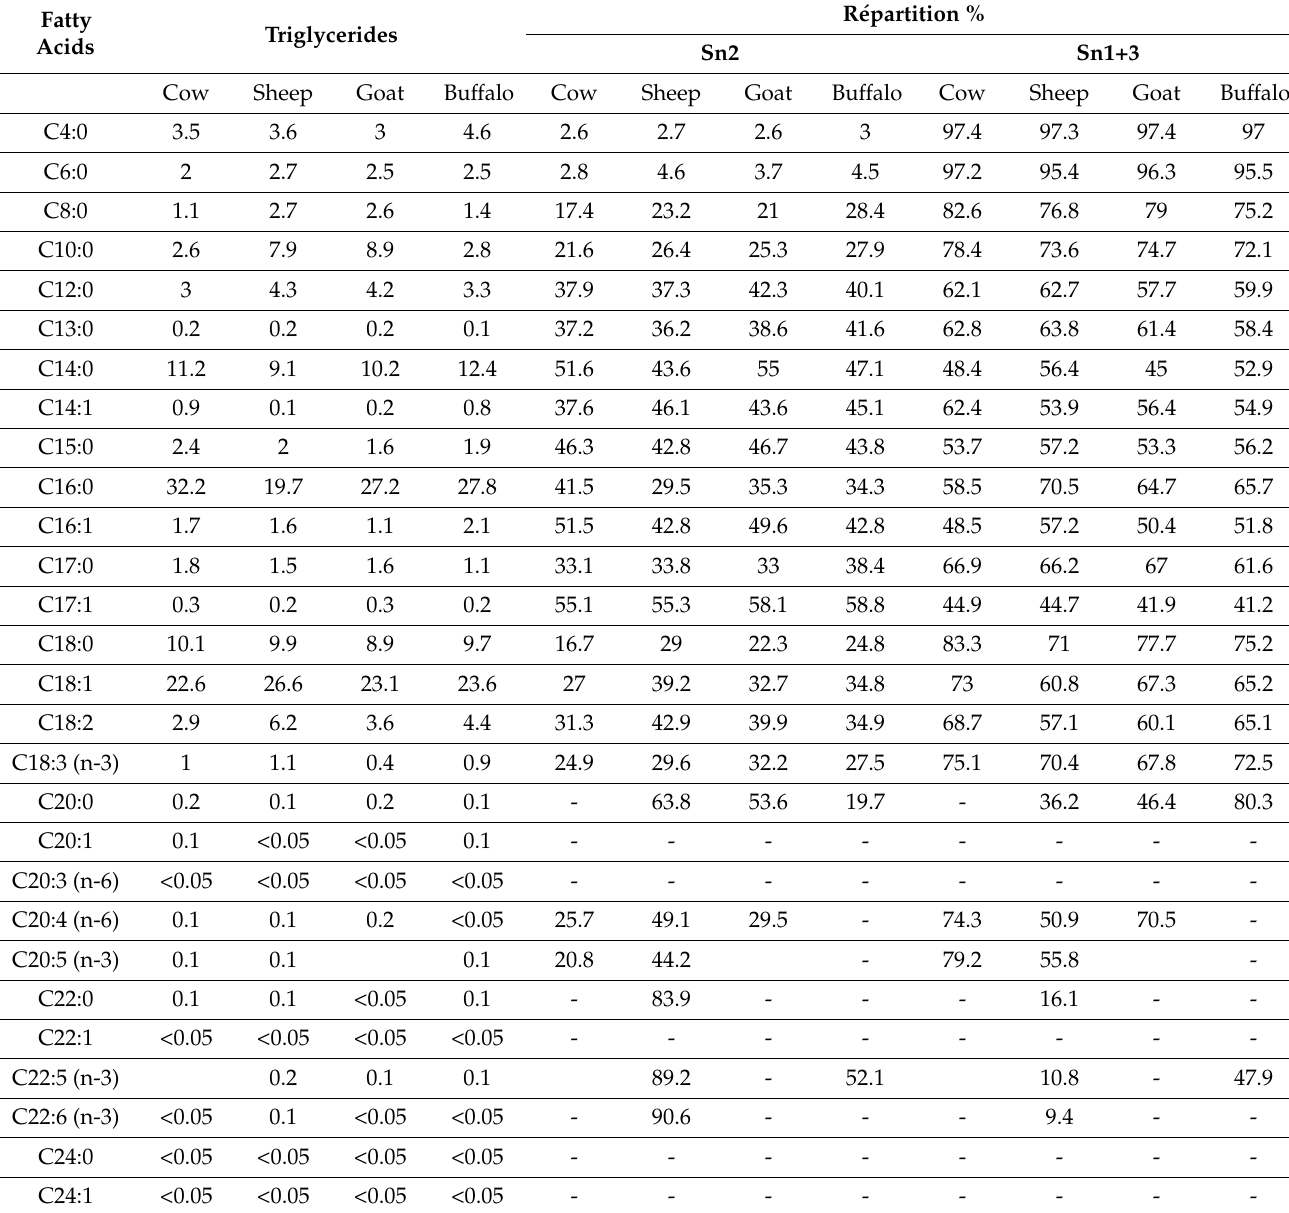
Table 6. Fatty acid composition in the sn-2 position of the triglyceride molecules in cream samples from cow, buffalo, goat and sheep cream